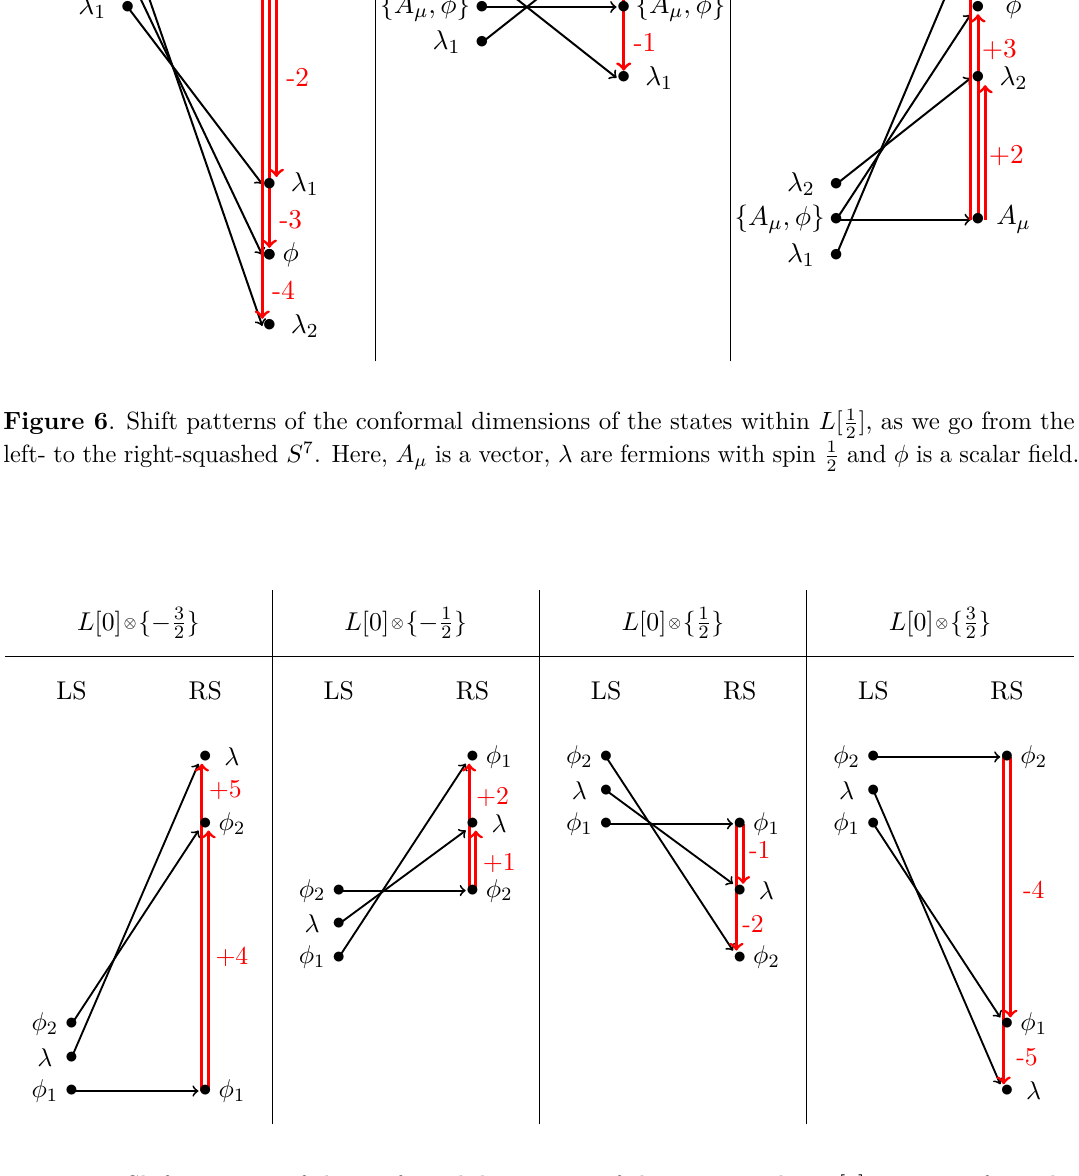
and φ are scalar 2